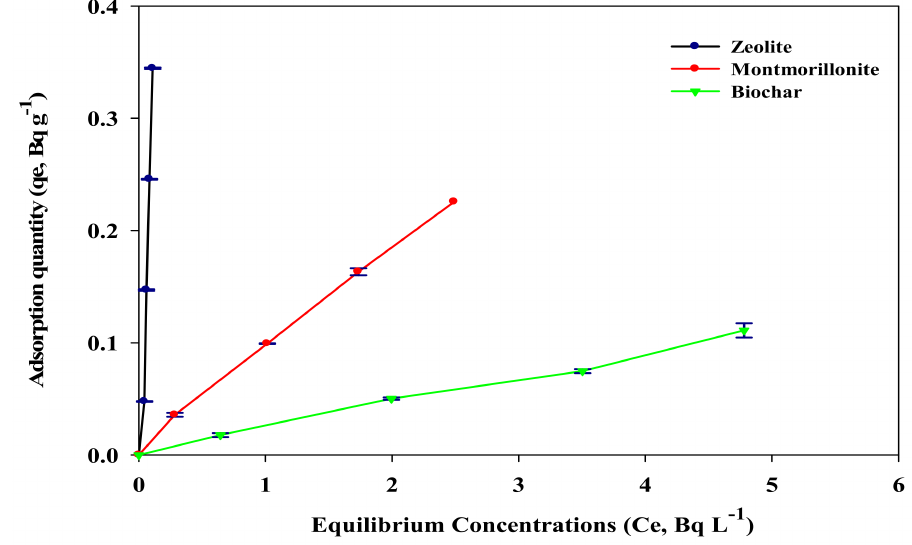
Figure 1. The 226 Ra equilibrium adsorption isotherms for the investigated sorbents (at pH = 5,